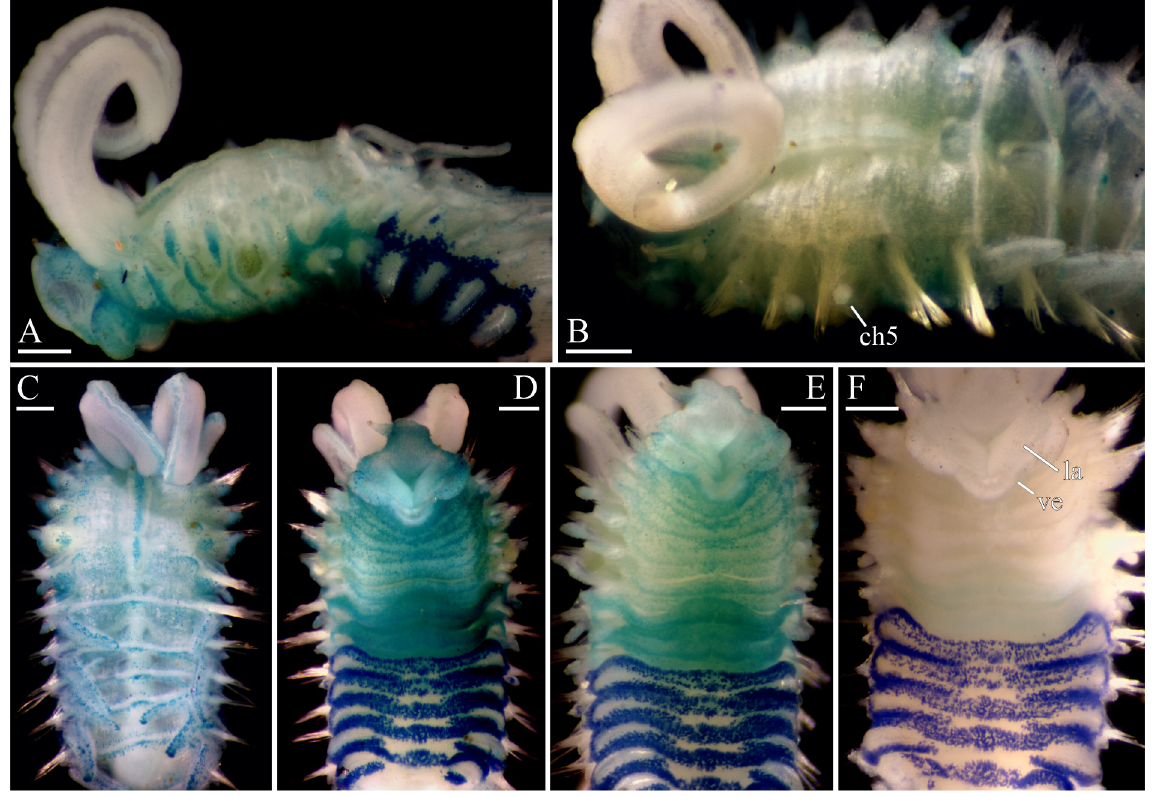
Fig. 20. Adult morphology of Pseudopolydora multispinosa sp. nov., holotype (MIMB 40906, formalin- fixed and stained with MG). A–C . Anterior end, left lateral (A) and dorsal (B–C) view. D–F . Anterior end, ventral view, showing changing of MG staining in time after return of the specimen to clean ethanol: after 1 minute (D), after 15 minutes (E), after 1 hour (F). Abbreviations: ch5 = chaetiger 5; la = lateral peristomial lip; ve = ventral peristomial lip. Scale bars = 200